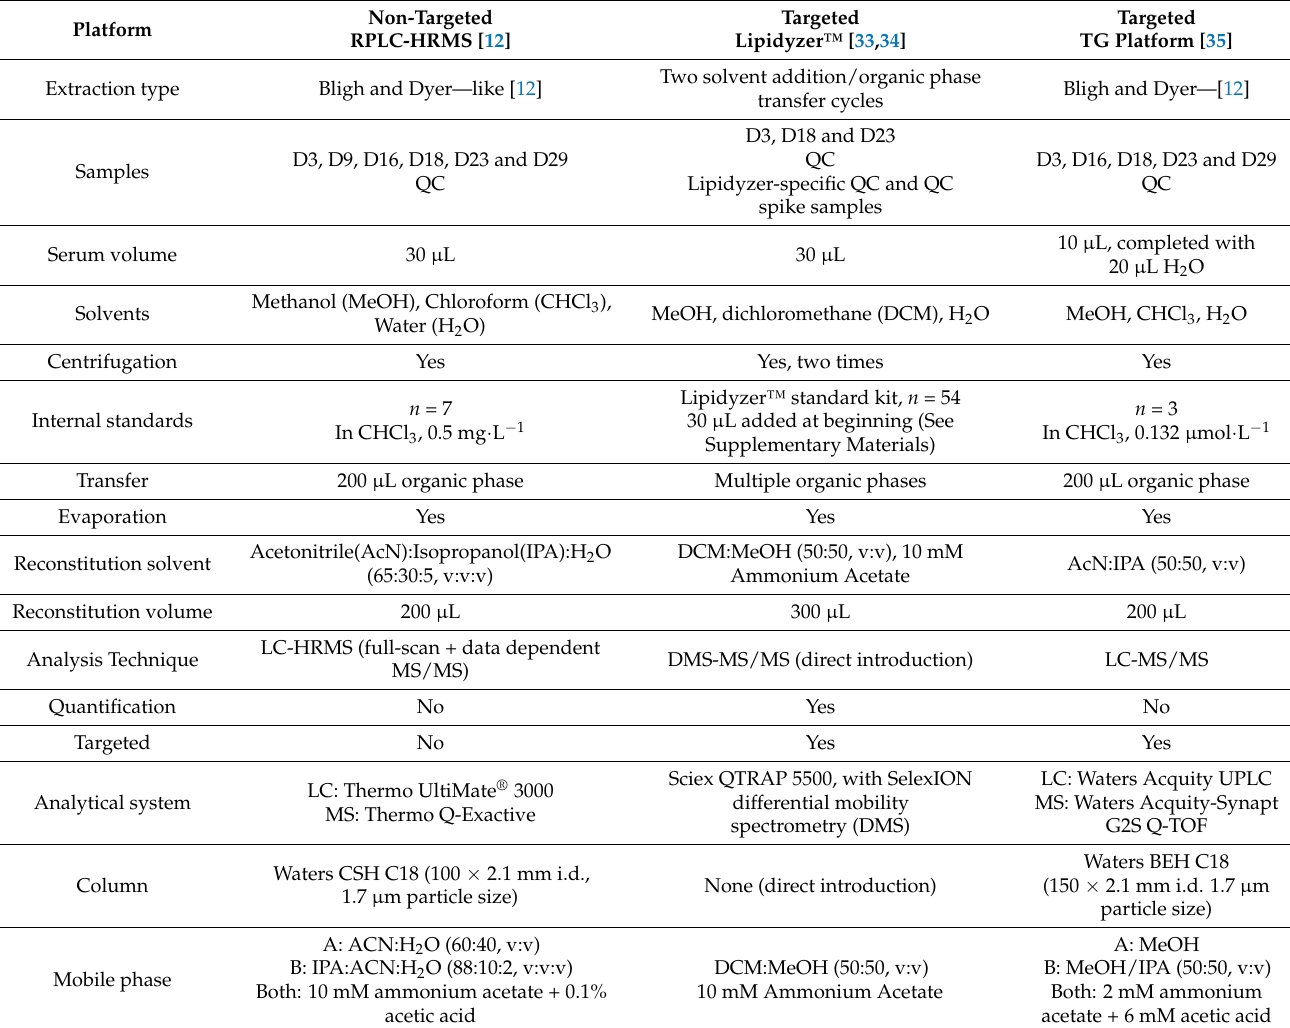
Table 1. Characteristics of the three used platforms and associated experimental